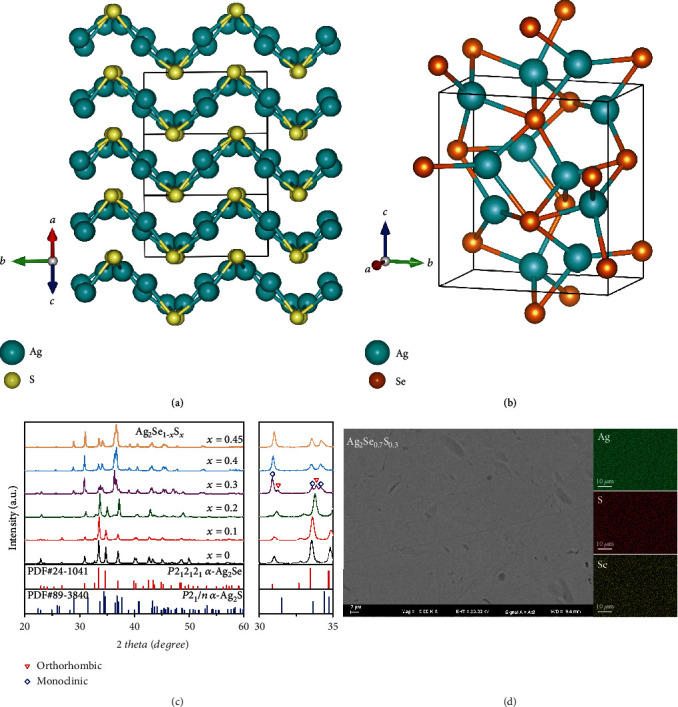
Crystalline structures for (a) monoclinic Ag2S and (b) orthorhombic Ag2Se. (c) Room-temperature X-ray diffraction patterns for Ag2Se1‐xSx (x = 0, 0.1, 0.2, 0.3, 0.4, and 0.45) samples. The right panel shows the magnification around 2θ = 30 ~ 35°. (d) Backscatter electron (AsB) image and elemental energy dispersive spectroscopy (EDS) mappings of Ag2Se0.7S0.3.